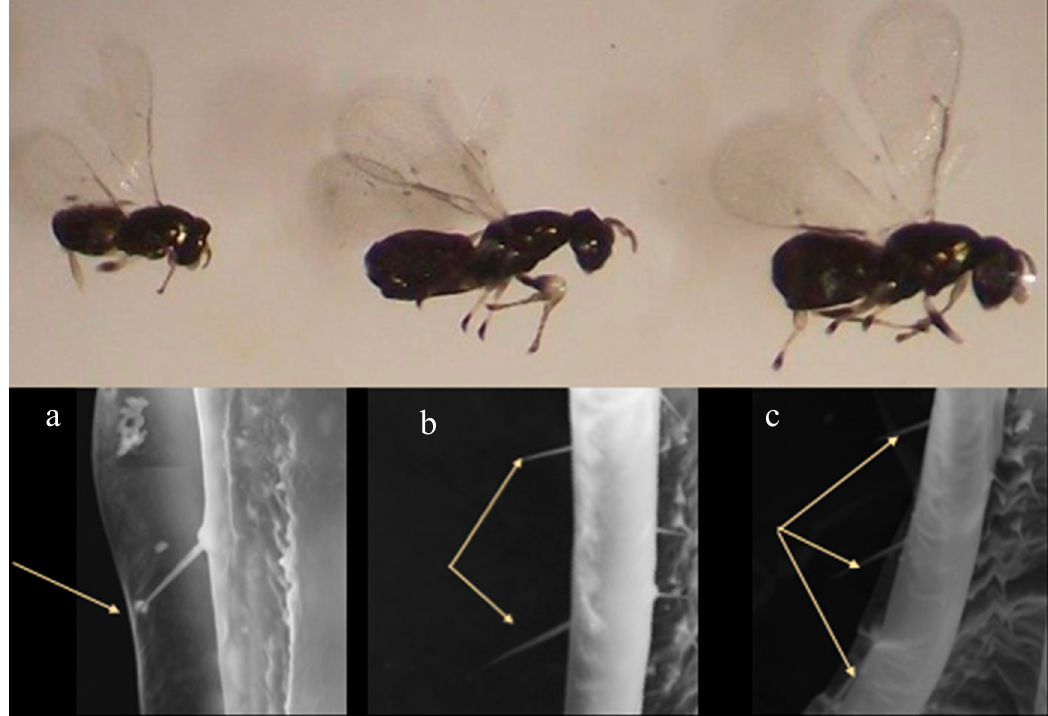
Figure 1. Ophelimus migdanorum nov sp., with ( a ) one setae on a sub marginal vein, ( b ) two setae on a Figure 1 Ophelimus migdanorum nov sp., with (a) one setae on a sub marginal vein, (b) two setae on a sub marginal vein, and ( c ) 3 setae on a submarginal sub marginal vein, and (c) 3 setae on a submarginal vein.